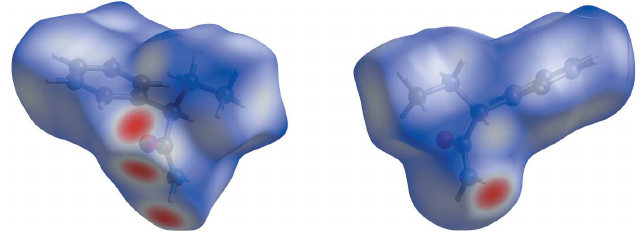
Figure 5 Hirshfeld surface for the rac -1 polymorph plotted over d norm in the range (cid:3) 0.5239 to 1.3882 a.u.